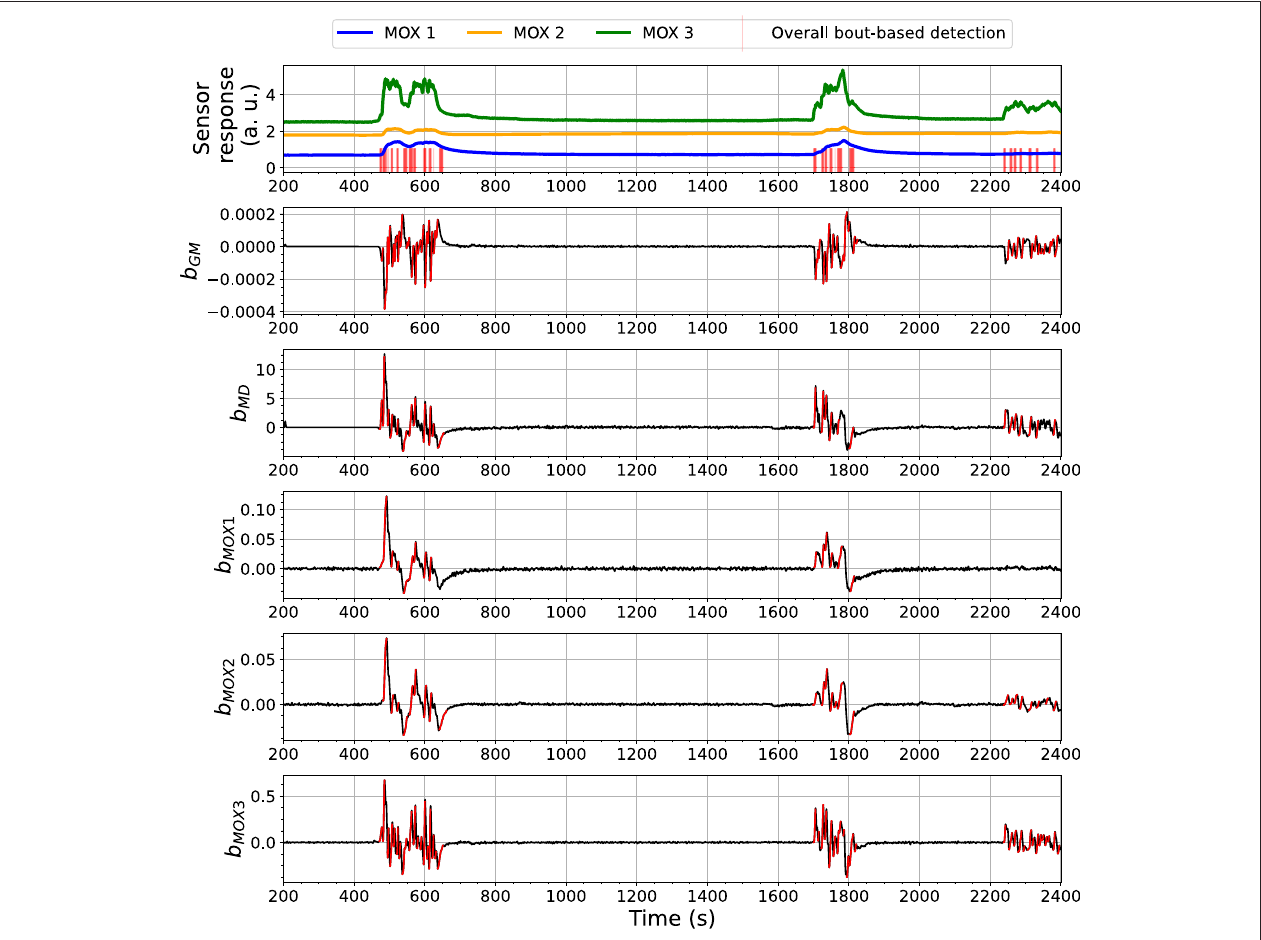
FIGURE 7 | Bout analysis and the prediction result of the Bout-Count Detection (BCD) model using FireNose on the Exp. 3-source trial. The overall bout detection madebytheBCDmodelisvisualizedinthetopsub fi gure,wheretimestepswithinthedurationofafoundboutaremarkedwithredverticallines.Thedetectedand fi ltered boutsineachsignalarehighlightedinredintherestsub fi gures.Azoomed-insnapshotofthispredictionresult,shownin Figure9 ,willillustratestheassociationbetween the overall bout detection and the individual bout detection on each signal.